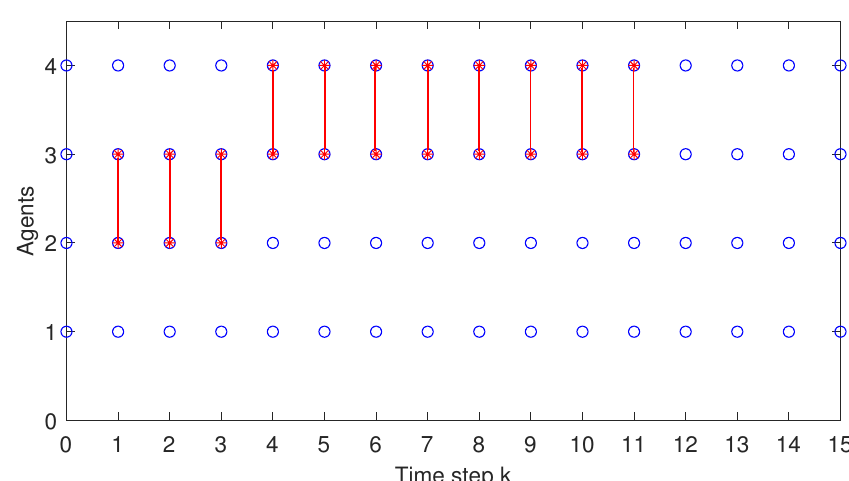
Figure 13. Test 8 —Coalitions formed at each time